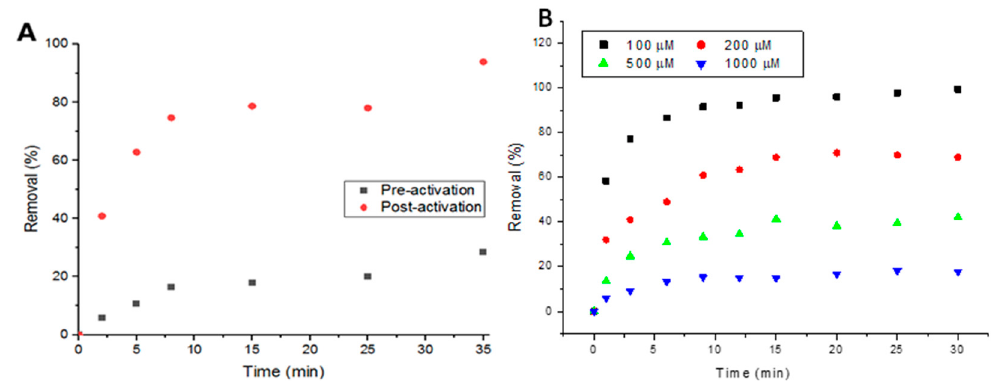
Figure 3. ( A ) Performance of metal-organic framework (MOF) pre- and post-activation with 100- μ M solutions of Doxycycline and ( B ) Effect of solution concentration on percent removal.